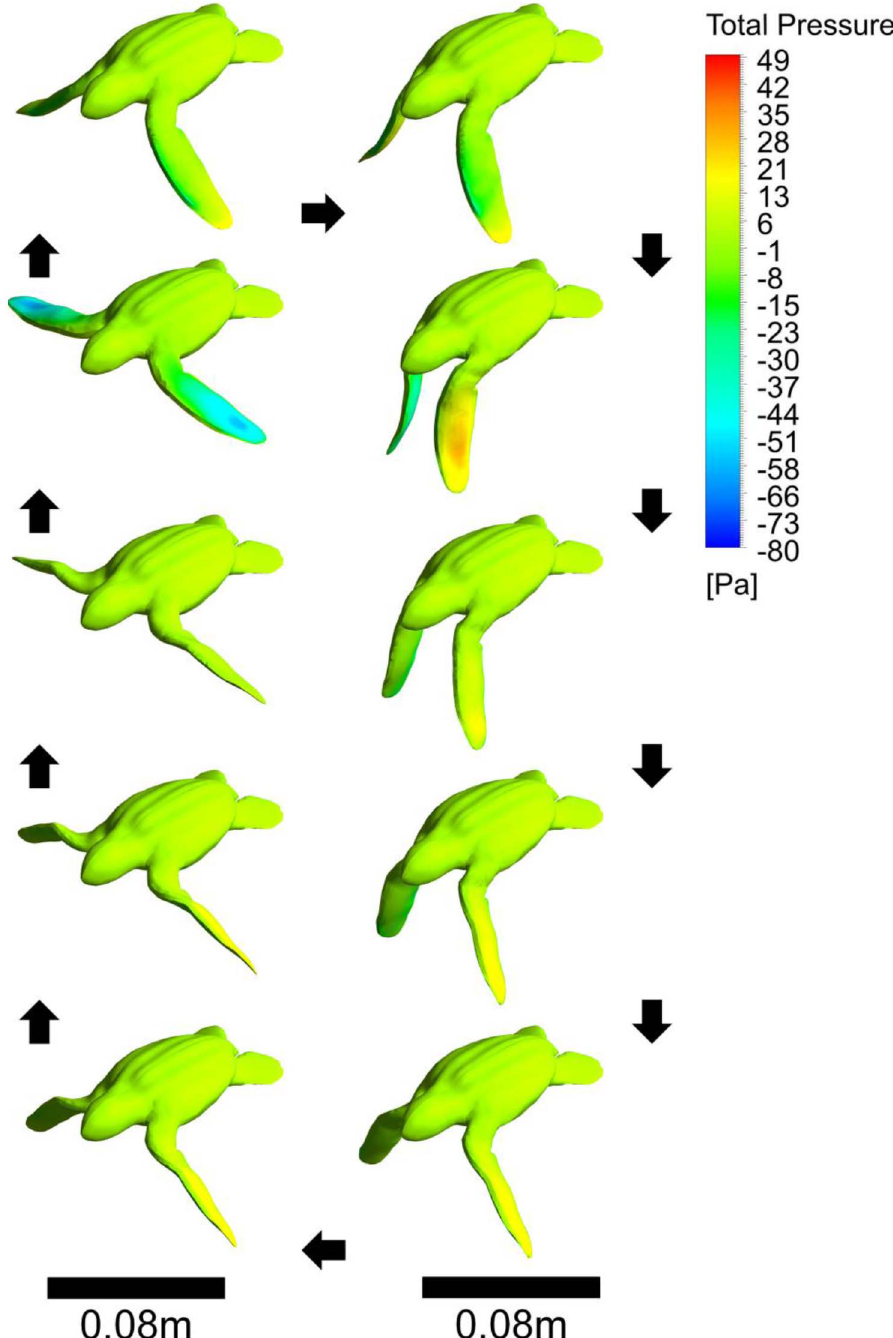
Figure 5. The pressure contours on the neonate turtle as it moves through one stroke period. Black arrows indicate the direction of the image sequence. This is an orthographic projection. The middle image in the left column represents one of the high negative thrust points recorded at the start of the bottom phase.